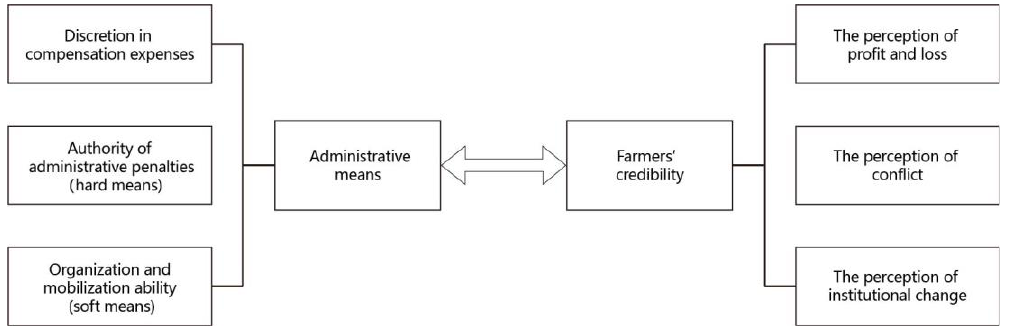
Figure 3. Schematic diagram of the effect of administrative means of lower governments on the credibility of farmers.